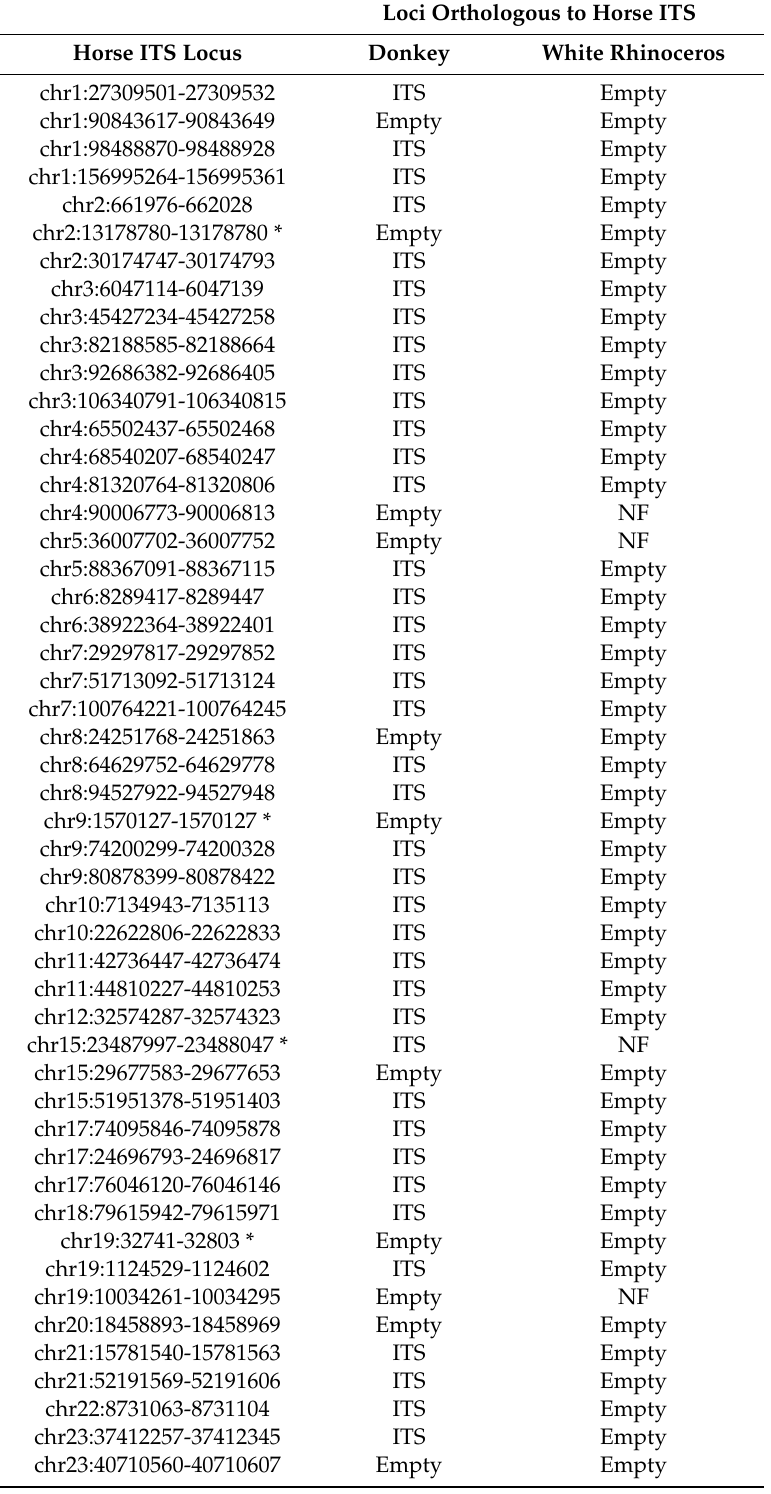
Table 4. Horse ITS loci informative for the mechanisms of telomeric repeat insertion. Loci are ranked by coordinate. Legend: ITS, telomeric repeats are present at the insertion site; Empty, the orthologous locus is empty at the insertion site; NF, orthologous locus not